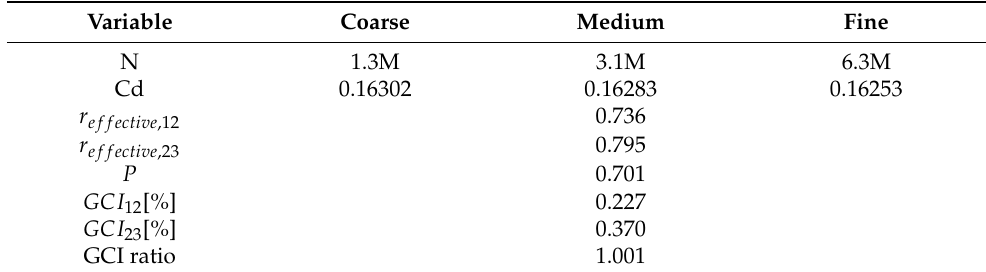
Table 3. Summary of GCI